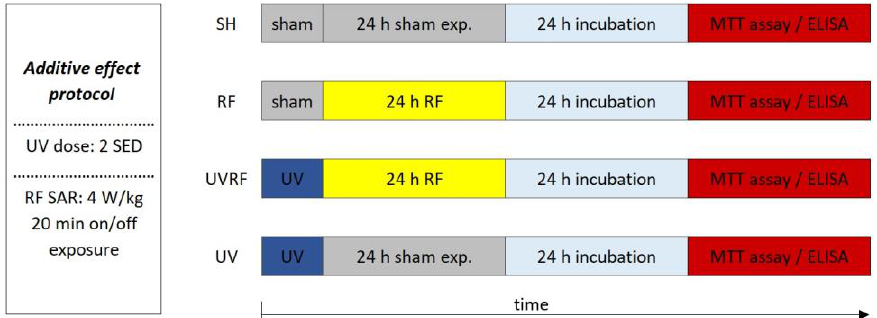
(b) Figure 4. ( a ) Spectral measurement, the UV exposure system of the solar simulator (Hönle SOL-500) equipped with a wavelength filter; ( b ) spectral irradiance of the solar simulator filtered with the lid of a Petri dish. 4.4. Experimental Protocols The sequence of exposures to UV and RFs depended on the appropriate study pro- tocol. In the case of the first study — for better understanding called the additive effect pro- tocol — 2 SED UV irradiation (as the first exposure) was followed immediately by 24 h of RF irradiation with 4 W/kg as the second exposure (Figure 5). The following four exposure conditions were examined in the additive effect proto- col: